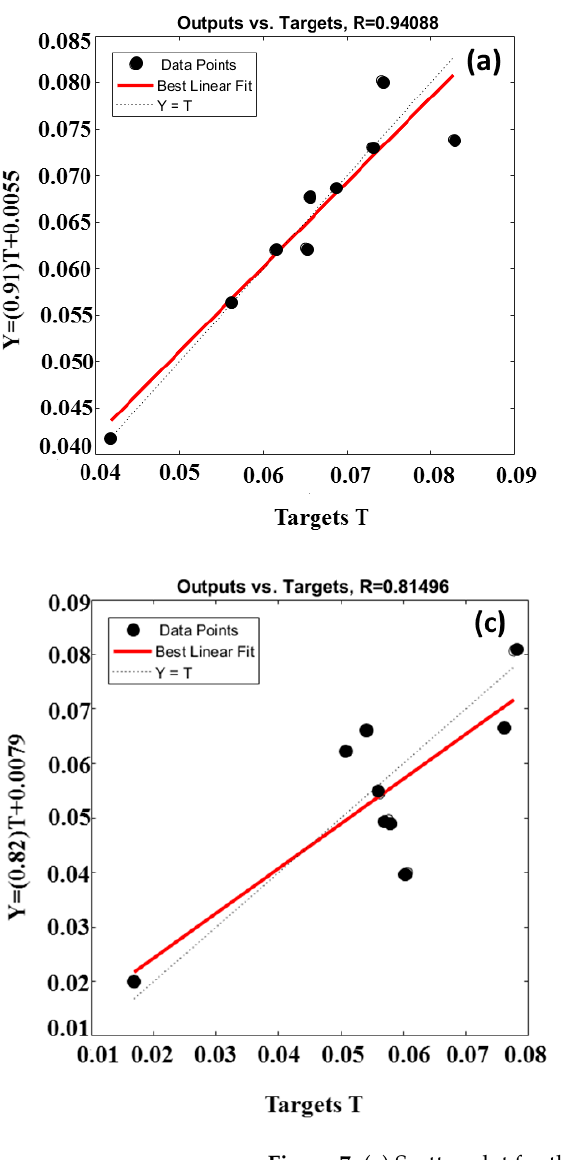
Figure 7. ( a ) Scatter plot for the circular grooves; ( b ) sensitivity analysis of the chosen ANN model for the circular grooves; ( c ) scatter plot for the perpendicular grooves; ( d ) sensitivity analysis of the chosen ANN model for the perpendicular grooves. chosen ANN model for the perpendicular